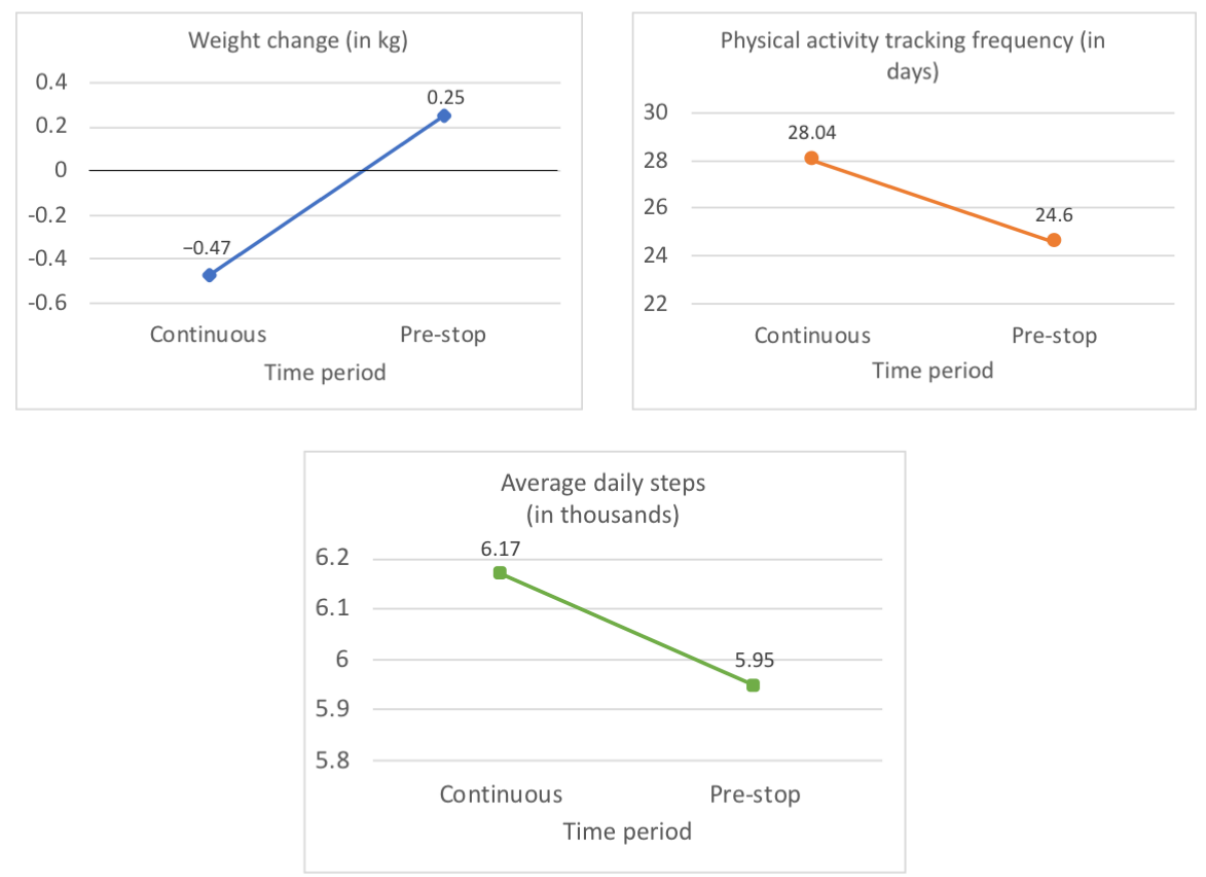
Figure 5. Results of the three linear mixed effects models for research question